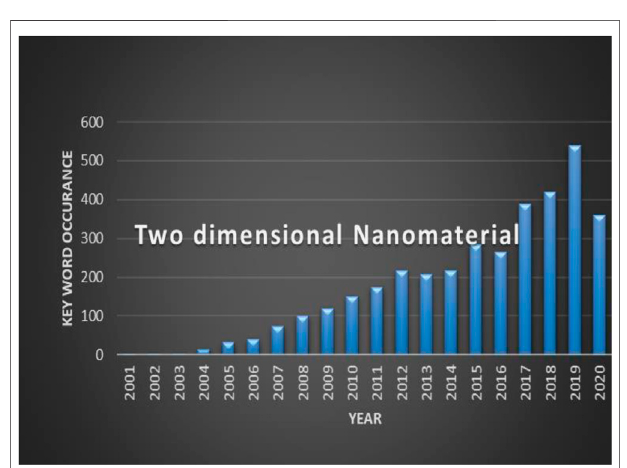
FIGURE 5 | Keyword occurrences in Scopus documents from 2001 to